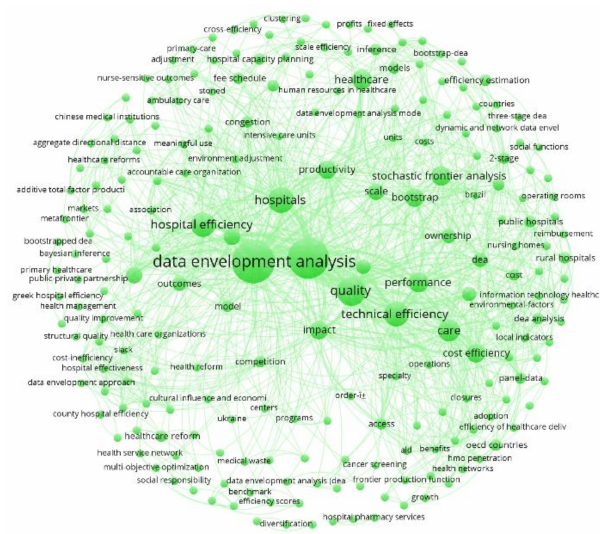
Figure 7. Keywords Co-occurrence for the Green